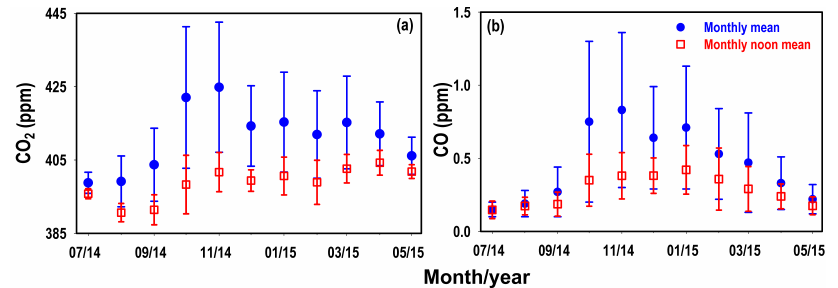
Figure 4. The seasonal variation of CO 2 and CO from July 2014 to May 2015 using their monthly mean concentrations. The blue dots and red rectangles show the monthly average concentrations of these gases for the total (0–24h) and noontime (12:00–16:00) data respectively with 1 σ spread.